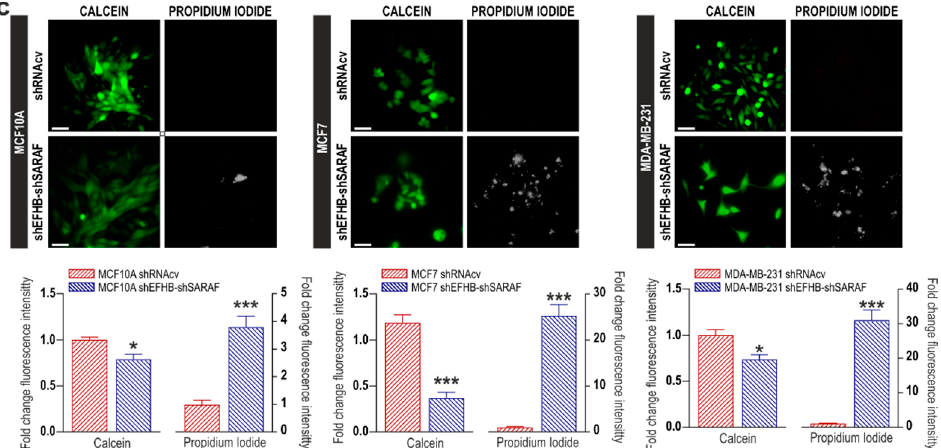
Figure 3. Attenuation of EFHB and SARAF expression reduces viability in breast cancer and pre-neoplastic cells. MCF10A, MCF7, and MDA-MB-231 cells were transfected with shEFHB alone or in combination of EFHB expression plasmid ( a ) shSARAF alone or in combination with SARAF expression plasmid; ( b ) shEFHB and shSARAF; ( c ) or scramble plasmids (shRNAcv), as indicated. Forty-eight hours after transfection, cells were loaded with calcein (green) and propidium iodide (white) and cell staining was visualized using an inverted microscope, as described in Material and Methods. Bar graphs represent calcein and propidium iodide staining under the different conditions expressed as fold change experimental over control (cells transfected with shRNAcv) and presented as mean ± SEM. Images shown are representative of 6–8 independent experiments. * p < 0.05 ** p < 0.01 and *** p < 0.001, compared to the corresponding control. Scale bar: 100 µm.